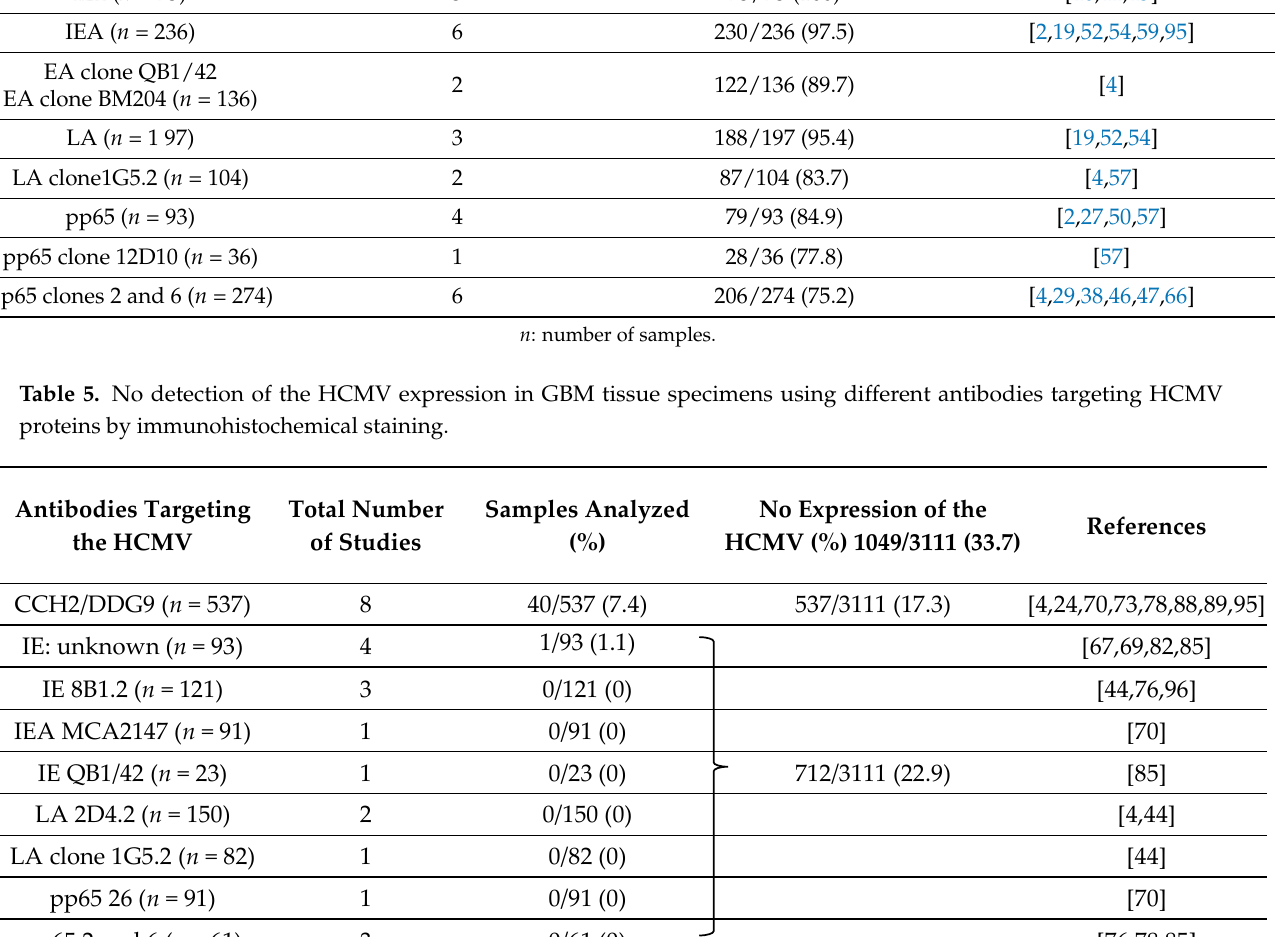
Table 4. Detection of the HCMV expression in GBM tissue specimens using different antibodies targeting HCMV proteins by immunohistochemical staining.